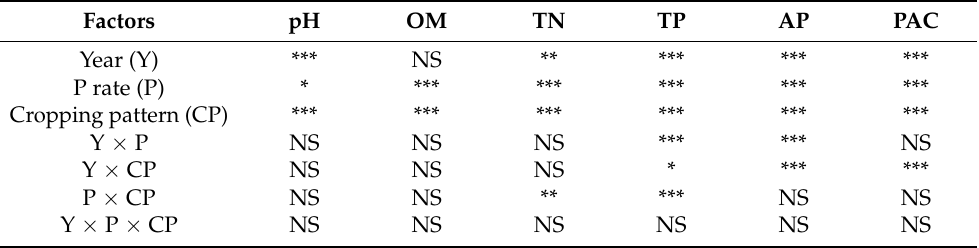
Table 3. Multi-factor analysis of variance of soil physiochemical properties in 2019–2020.